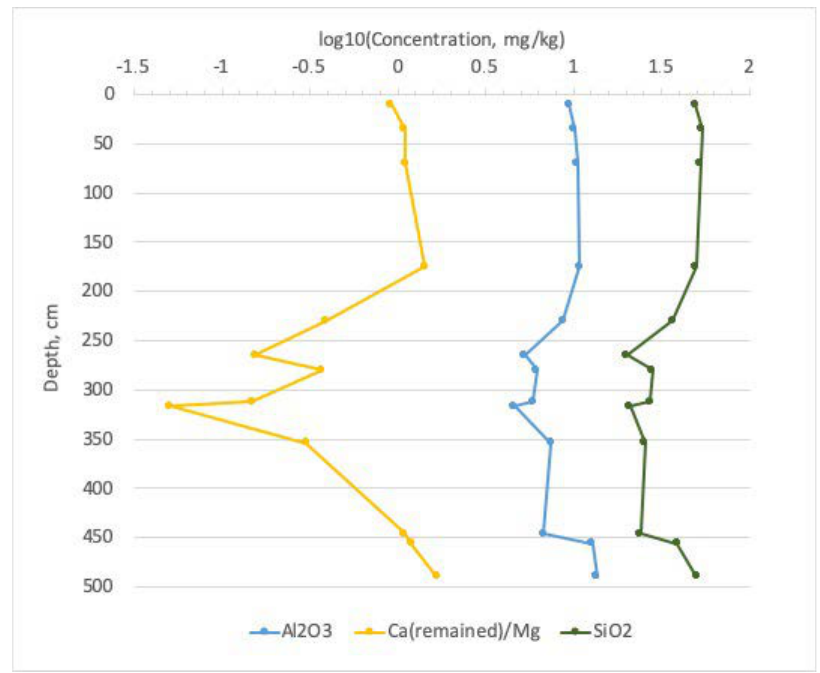
Figure 9. The logarithmic values of SiO 2 , Al 2 O 3 concentrations and Ca(remained)/Mg ratio. Ca(remained) was calculated by removing the amount of calcium needed for gypsum precipitation based on an average oxides composition of gypsum that is 32.57% of CaO, 46.5% of SO 3 , and 20.93% of H 2 O.